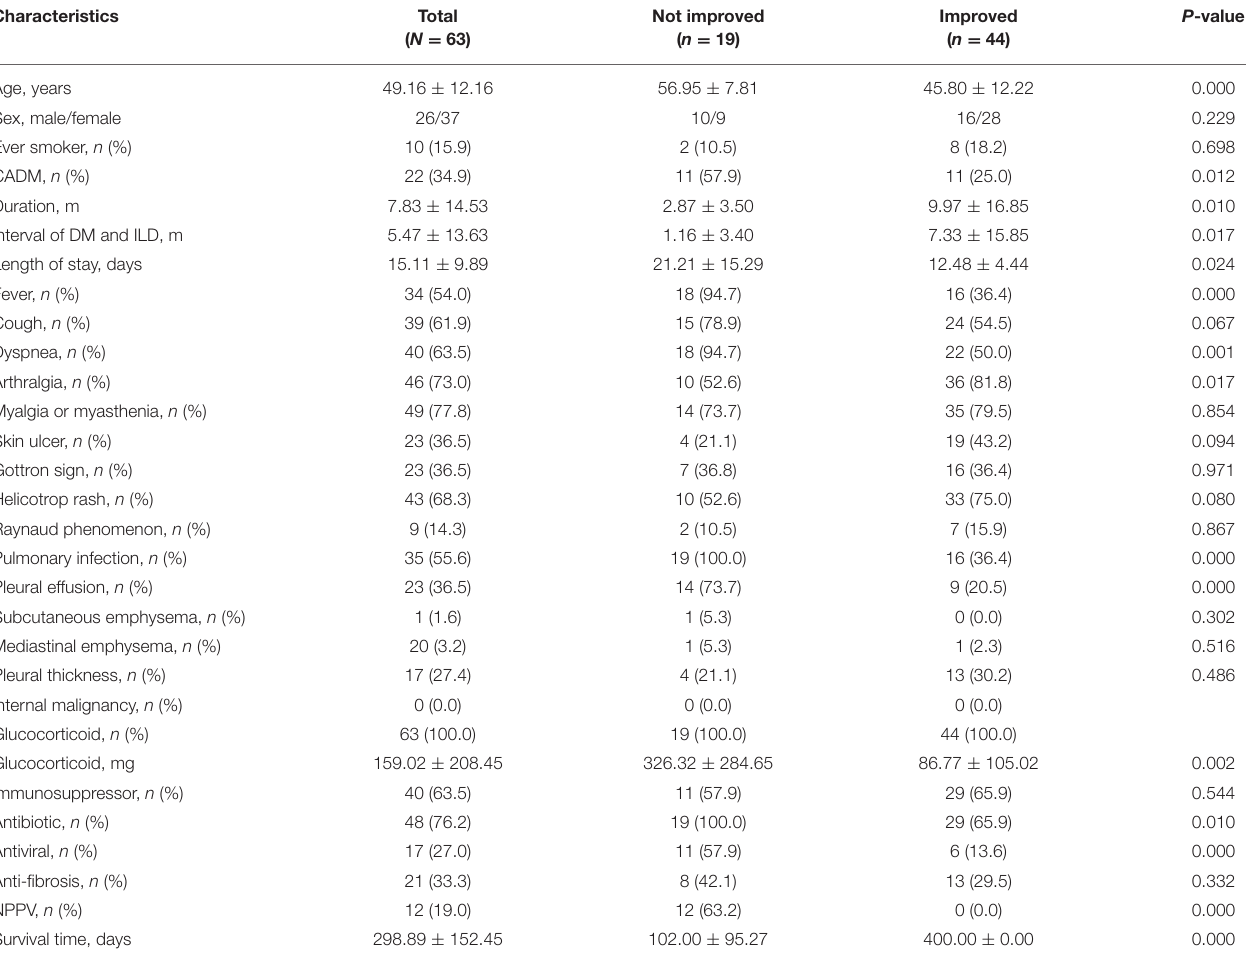
TABLE 1 | Basic information of MDA5 + DM-ILD.